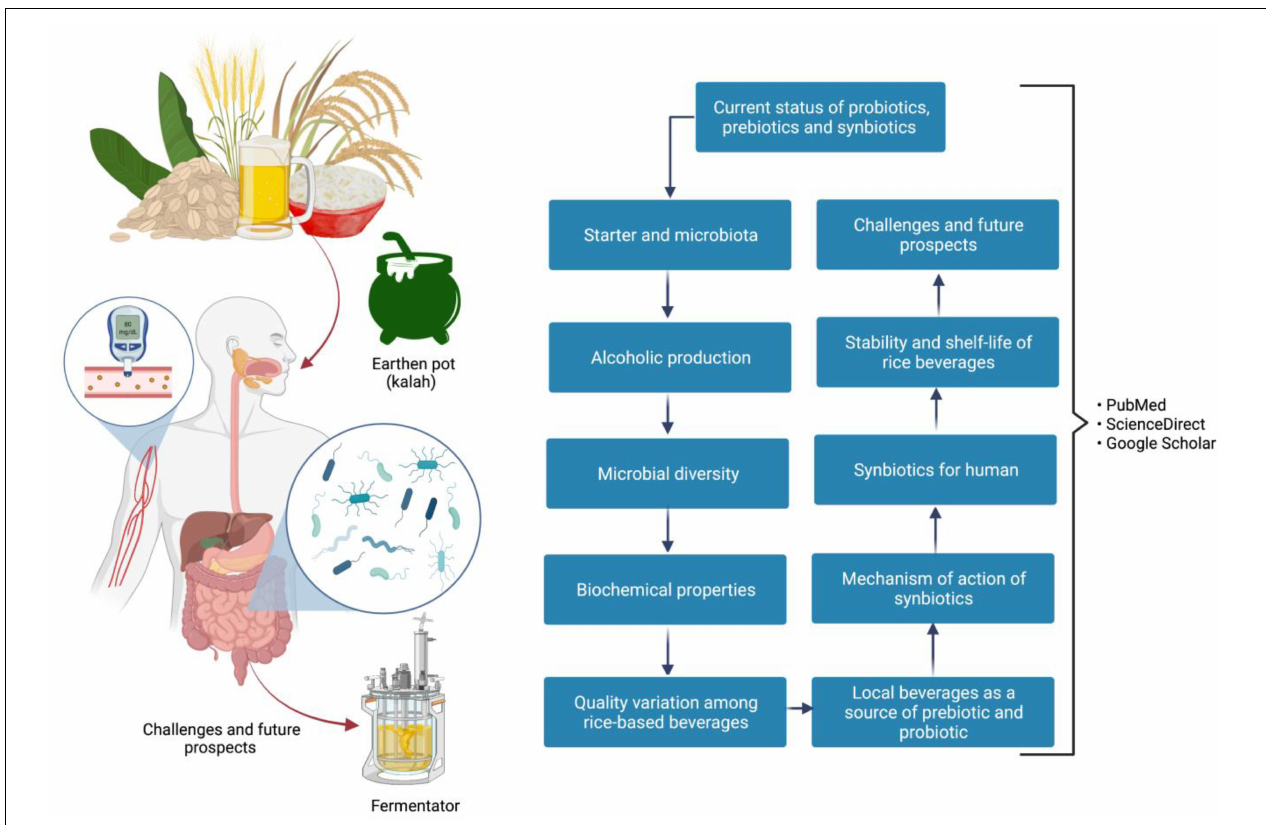
FIGURE 2 | Flow chart of literature